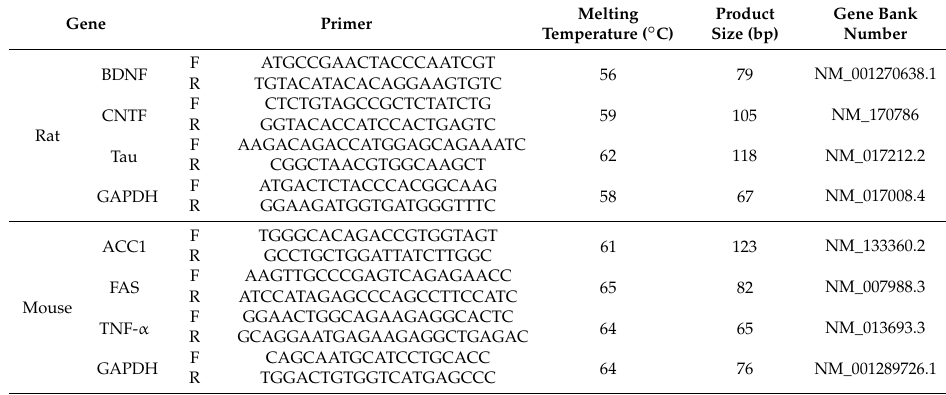
Table 1. The sequences and characteristics of primers used for real-time polymerase chain reaction (PCR)